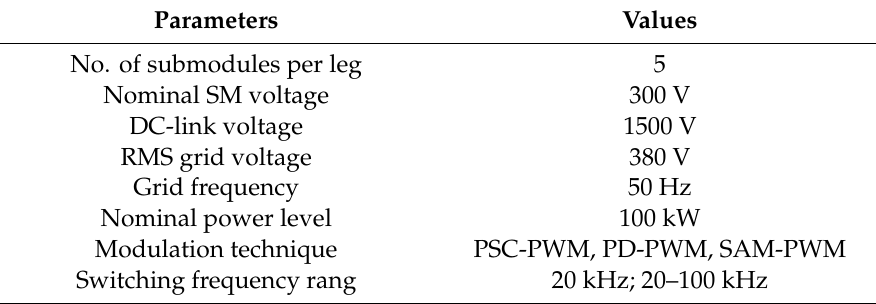
Table 3. MMC parameters for performance